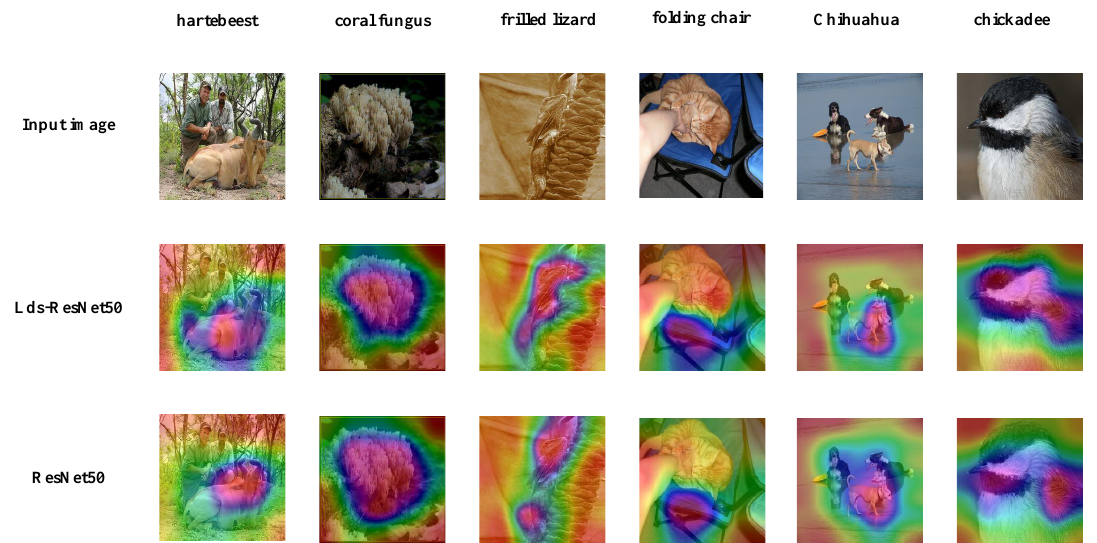
Figure 7. Grad-CAM [58] visualization results. We compare the visualization results between our Lds-ResNet50 and ResNet50. The Grad-CAM visualization is calculated for the last convolutional outputs. The ground-truth label is shown on the top of each input